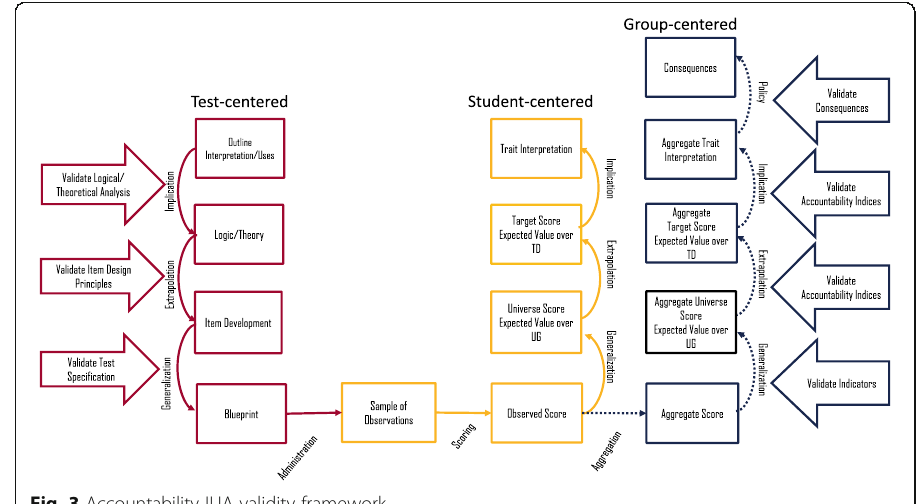
Fig. 3 Accountability IUA validity